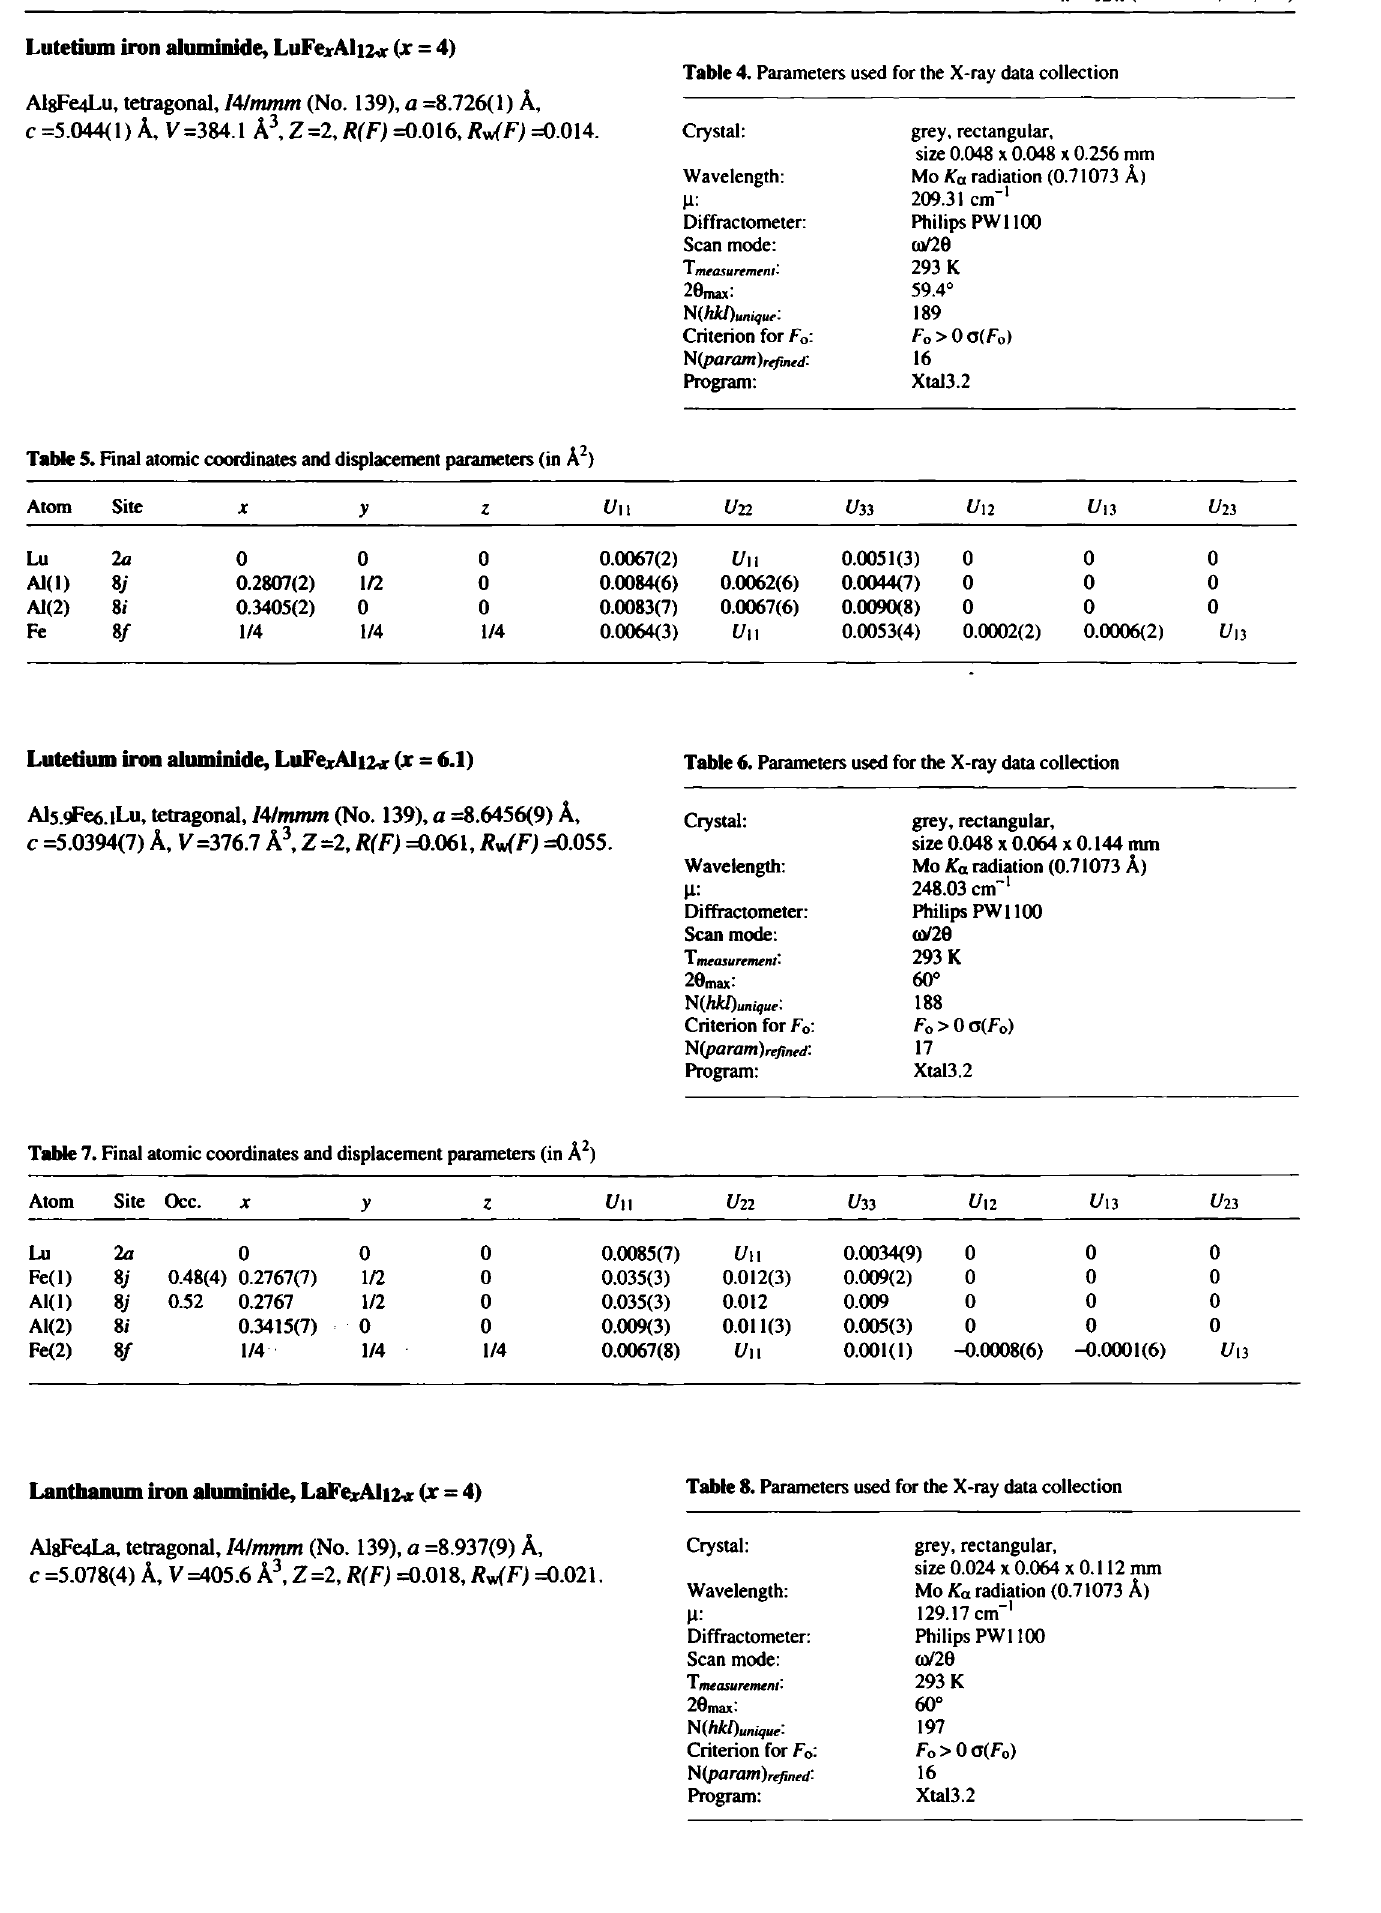
Table 4, Parameters used for the X-ray data collection